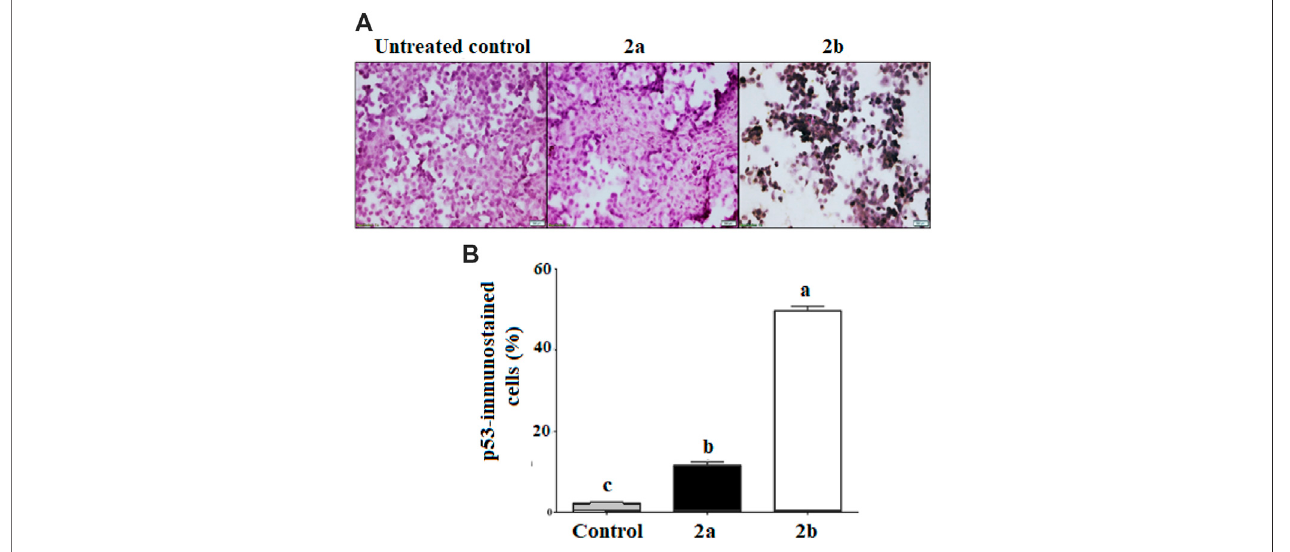
FIGURE12| p53 immunohistochemical analysisof p53 expression in 2a- and 2b -treated HepG-2cells. (A) Immunostainingimages ofp53-treated and untreated cells (magni fi cation × 400) with (B) representative percentages of the positive immunostaining HepG-2 cells. Different letters are signi fi cantly different at p < 0.05.